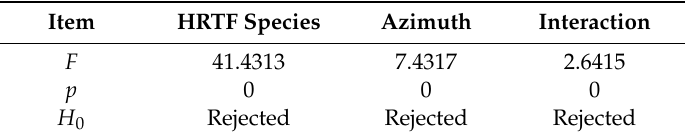
Table 8. The result of two-way repeated analysis of